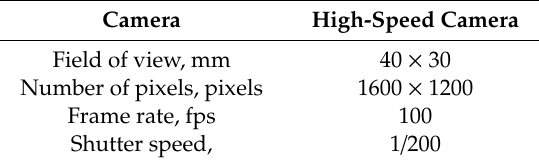
Table 5. Specification of the captured